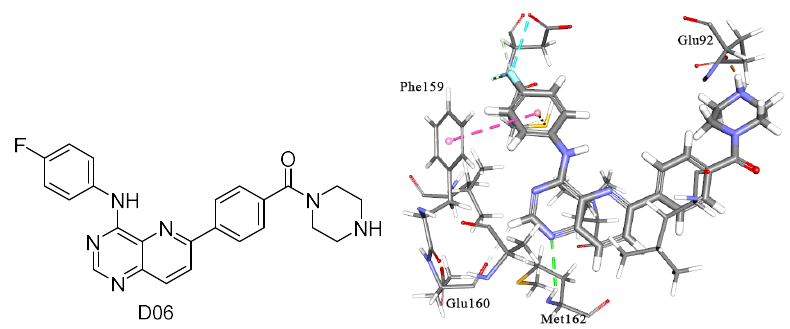
Figure 3. The structure of compound D06 and predicted binding mode of D06 with Mnk2.